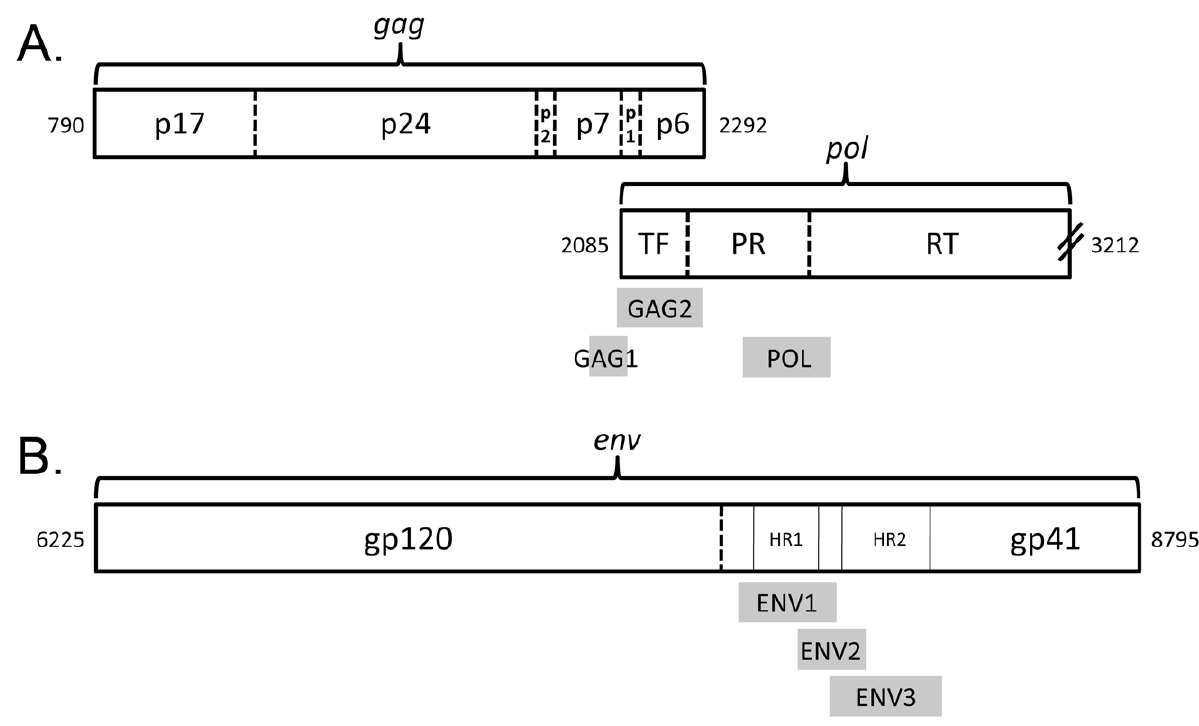
Figure 1. Regions of the HIV genome analyzed using the HRM diversity assay. The relevant regions of the HIV genome are shown (adapted from [39]). Numbers at the ends of each genomic segment correspond to coordinates in HXB2 (Genbank accession number: K03455). The amplicons used for HRM diversity analysis (regions analyzed) are indicated by shaded boxes. (A) Gag and pol amplicons: The GAG1 amplicon includes a portion of the coding regions for gag p7 and gag p1. The GAG2 amplicon includes the coding regions for gag p1 and gag p6 and extends into the coding region for HIV protease (PR); this amplicon also corresponds to the transframe (TF) protein. The POL amplicon spans the junction between the coding regions of HIV protease and HIV reverse transcriptase (RT). (B) Env amplicons: The ENV1 amplicon includes the coding region for heptad repeat 1 (HR1) of gp41, as well as portions of the coding regions to either side of HR1. The ENV3 amplicon includes the coding region for heptad repeat 2 (HR2), as well as portions of the coding regions to either side of HR2. The ENV2 amplicon includes the coding region for immunodominant region (IDR) cluster I of gp41, as well as portions of the coding regions for HR1 and HR2 [33].